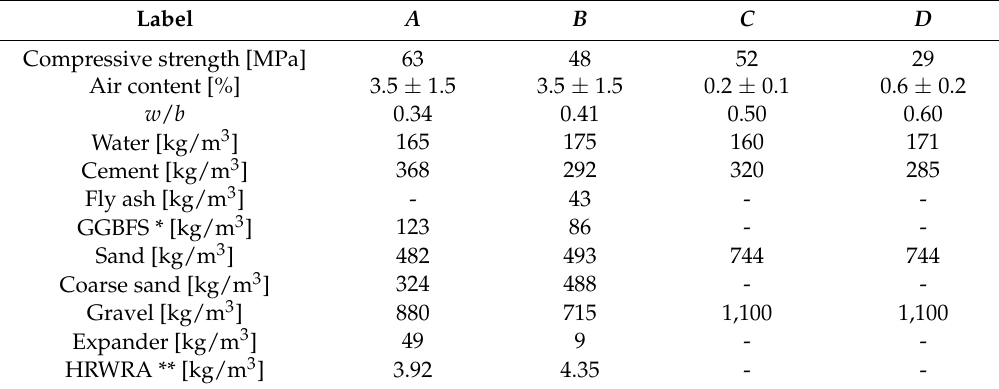
Table 1. Mix proportions of concrete samples.